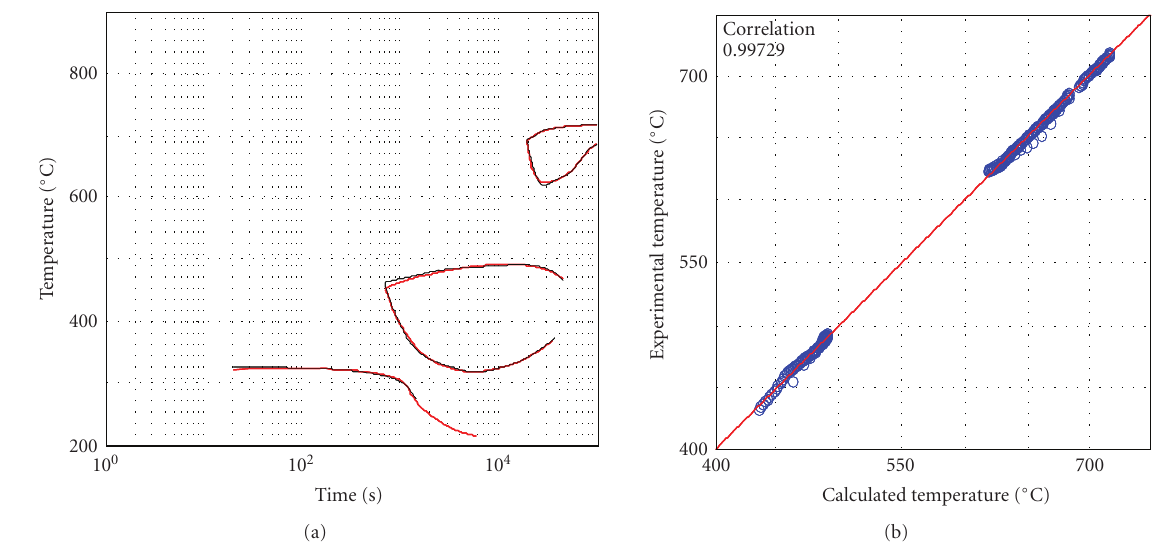
Figure 12: Results for tempering steel 34CrNiMo6 with a deformation of